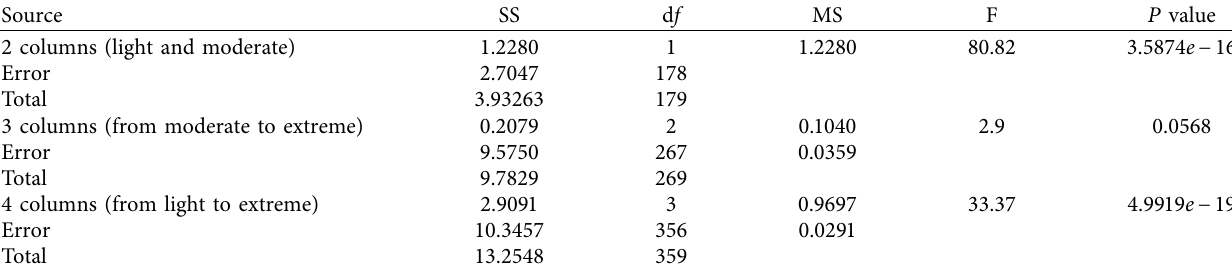
Table 6: One-way ANOVA test for BI variation ratio between varying rainfall